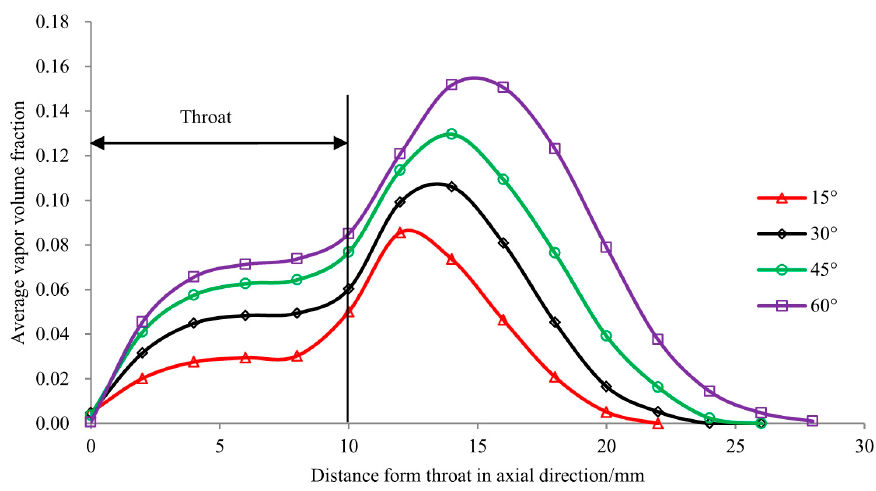
Figure 6. Average vapor volume fraction of cross-section form the throat in axial direction with di ff erent contraction